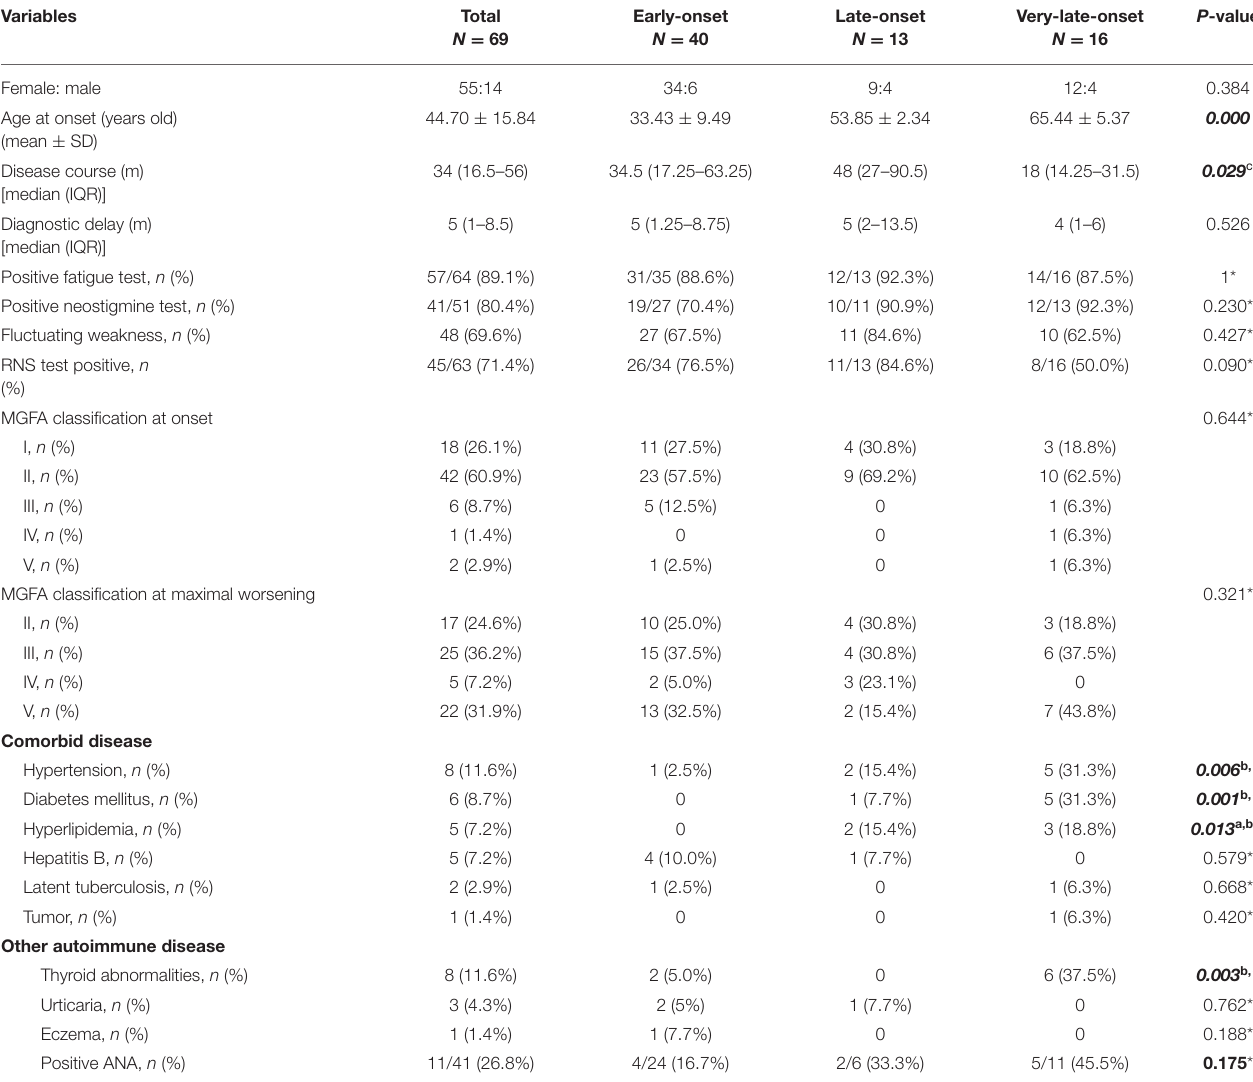
TABLE 1 | Clinical features of early-onset, late-onset, and very-late-onset MuSK-myasthenia gravis (MuSK-MG). Variables Total